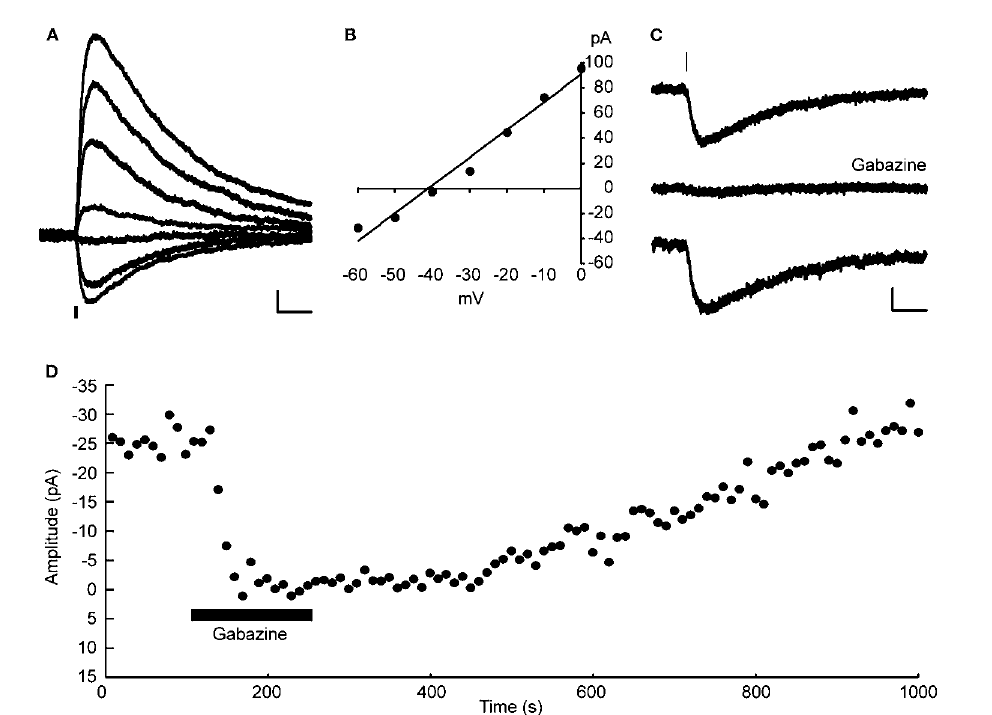
Figure 2 | RuBi-GABA uncaging activates GABA-A receptors. (A) RuBi-GABA uncaging responses collected at different holding potentials (every 10 mV from 0 to − 60 mV) showing the uncaging-induced current reversal close to the expected chloride reversal ( − 43 mV). The black bar below the traces indicates the uncaging laser pulse. (B) Current-voltage plot with a linear fi t to the peak amplitudes shown in (D) . (C) Average RuBi-GABA uncaging response before (top), during 20 μ M gabazine application (center), and after drug wash out (bottom). Responses were collected at − 70 mV of holding potential in K + -based internal solution with − 40 mV of chloride reversal. The black bar above the traces indicates the uncaging laser pulse. (D) Peak amplitude of uncaging responses as a function of time for the experiment shown in (C) . Scale bars: 10 pA, 50